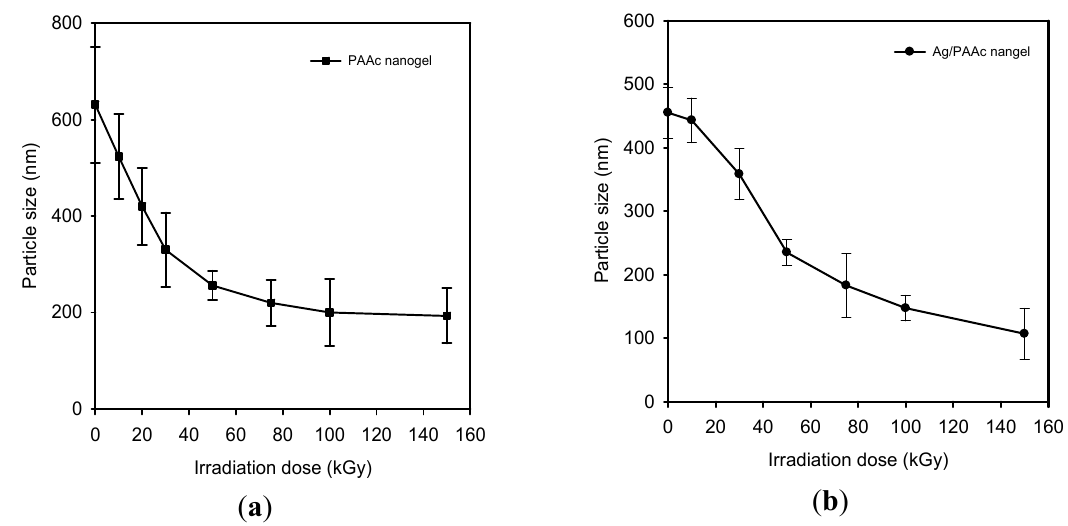
Figure 2. The particle size of ( a ) PAAc nanogel and ( b ) Ag/PAAc nanogel.